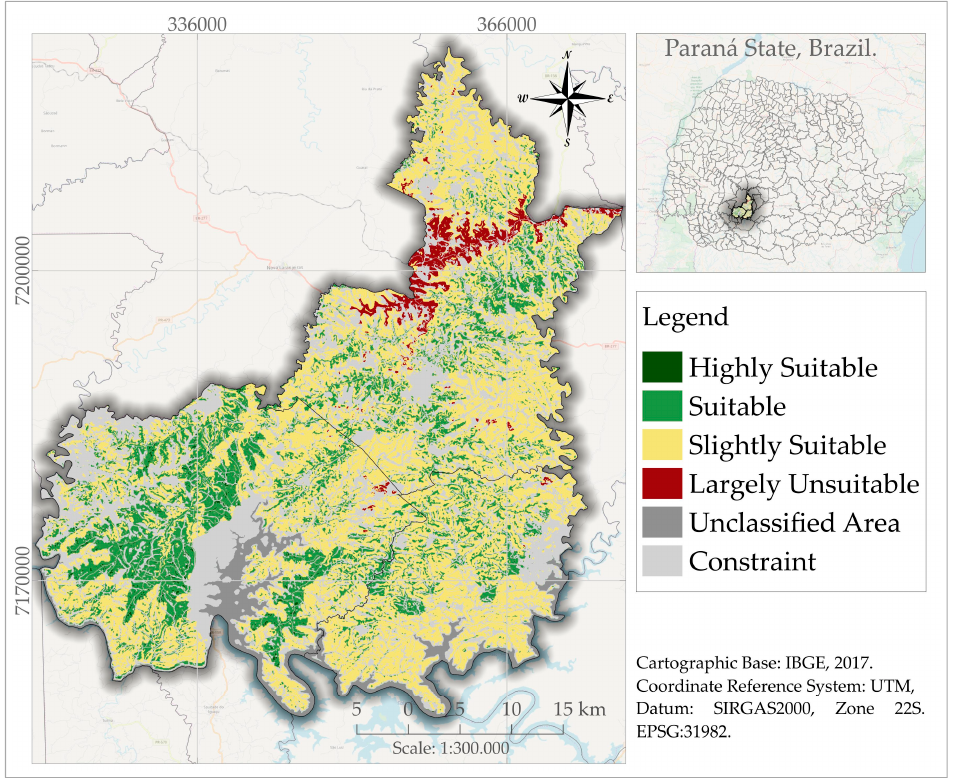
Figure 6. IP showing the fish farming suitability map of three cities located in Paraná State, Brazil.